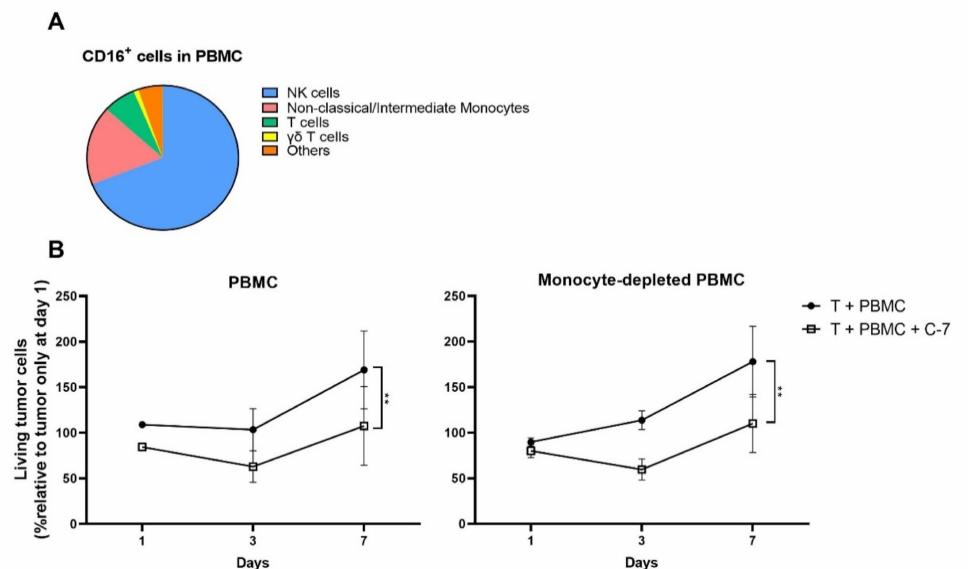
Figure 7. Tumor growth control mediated by the bispecific C-7 VHH in co-cultures of metastatic CRC cells and autologous PBMC is independent of effects on non-classical/intermediate monocytes. ( A ) Distribution of CD16 + cells in PBMC from patients with peritoneal CRC metastasis. n = 7. ( B ) Dissociated CRC peritoneal metastatic lesions ± 100 nM C-7 ± autologous PBMC or monocyte depleted autologous PBMC. E:T ratio: 5:1. n = 4. Incubated for 1, 3, and 7 days. Data are